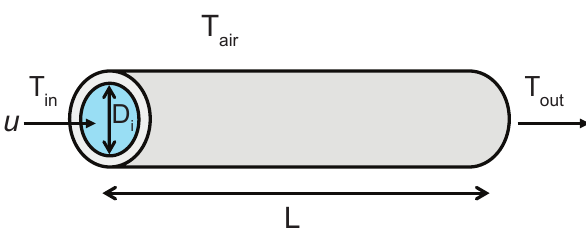
Fig. A1. Schematic of our model for warming of intake seawater by engine room air at temperature T air . The seawater is flowing at velocity u in a pipe of inside diameter D i . The initial seawater tem- perature is T in and the temperature after pipe length L is T out . We do not explicitly model a sea chest, rather we assume the temperature of the seawater in a sea chest is the same as that of the external sea- water beyond the inlet (i.e. T in ) . The model can thus be considered to represent a length of pipe inboard of a sea chest.